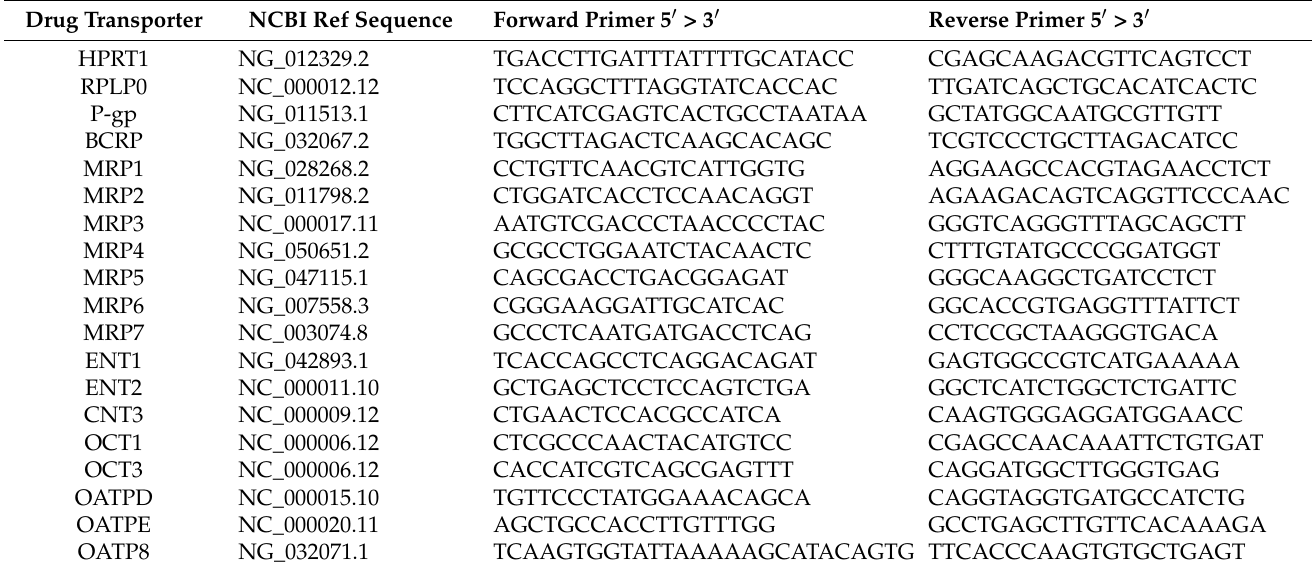
Table 1. Primer sequences used in gene expression